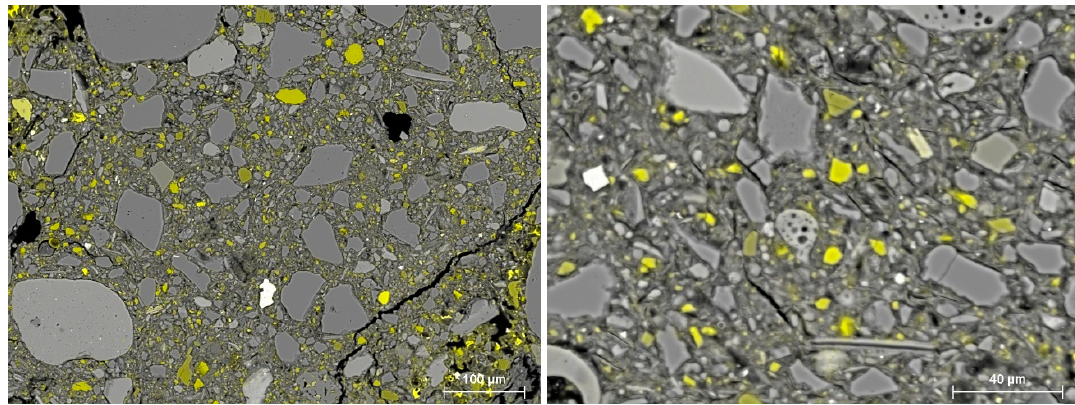
Figure 13. BSE image of a sample of MC III 9% CEM, showing the occurrence of calcium. The numerous carbonate grains are marked in yellow.